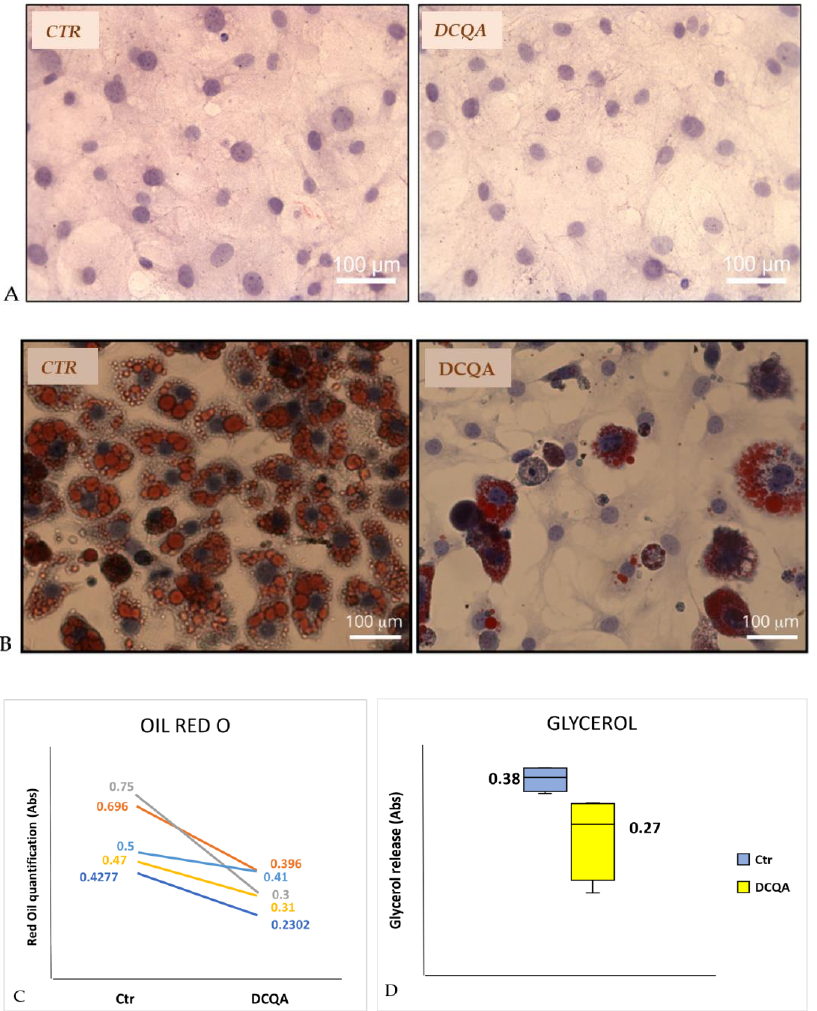
Figure 2. DCQA decreases adipocyte differentiation and glycerol release. ( A ) Pictures represent 3T3-L1 pre-adipocytes after staining with Oil Red O and Hematoxylin. CTR (not-treated sample); DCQA (sample treated with 10 µM DCQA); ( B ) pictures represent terminally differentiated adipocytes after staining with Oil Red O and Hematoxylin. CTR (not-treated sample); DCQA (sample treated with 10 µM DCQA for 10 days); ( C ) quantification of Oil Red O staining at the end of treatment. The absorbance values at 500 nm (for ml of isopropanol) of five independent experiments were shown in the figure. Difference between CTR- and DCQA-treated samples is statistically significant p < 0.02 (Student’s t -test for paired samples); ( D ) figure shows glycerol release in the culture medium by not-treated cells (CTR) and DCQA-treated cells for all time of differentiation process (DCQA). The difference is statistically significant ( p < 0.05).